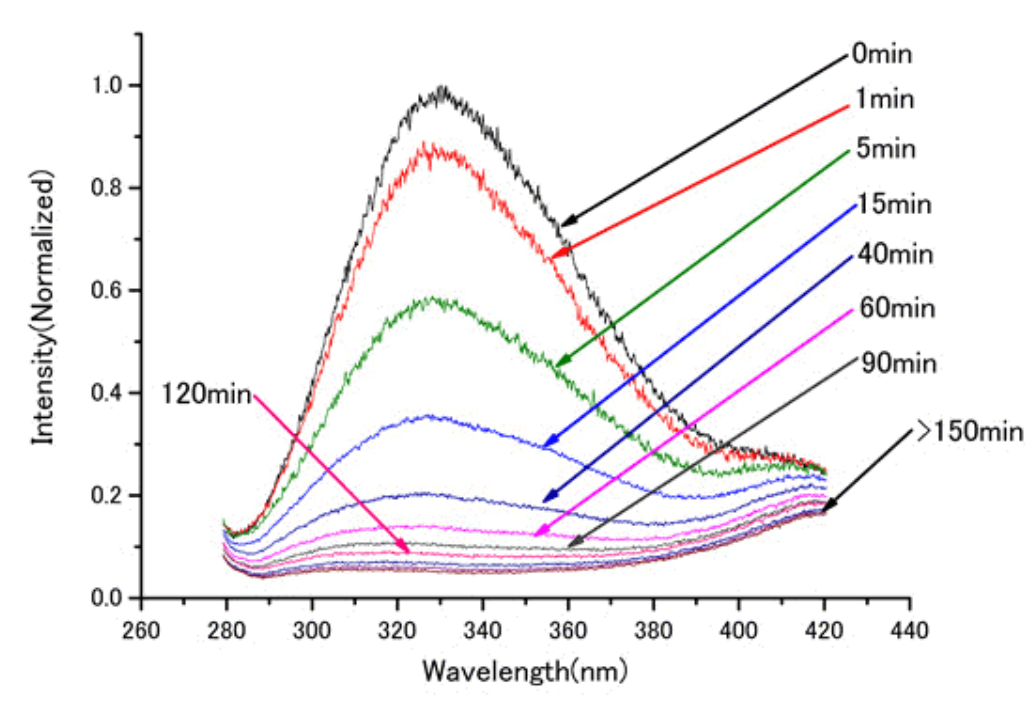
FIGURE 4. Time variation of peak A. These spectra were measured with 10-nsec delay time.